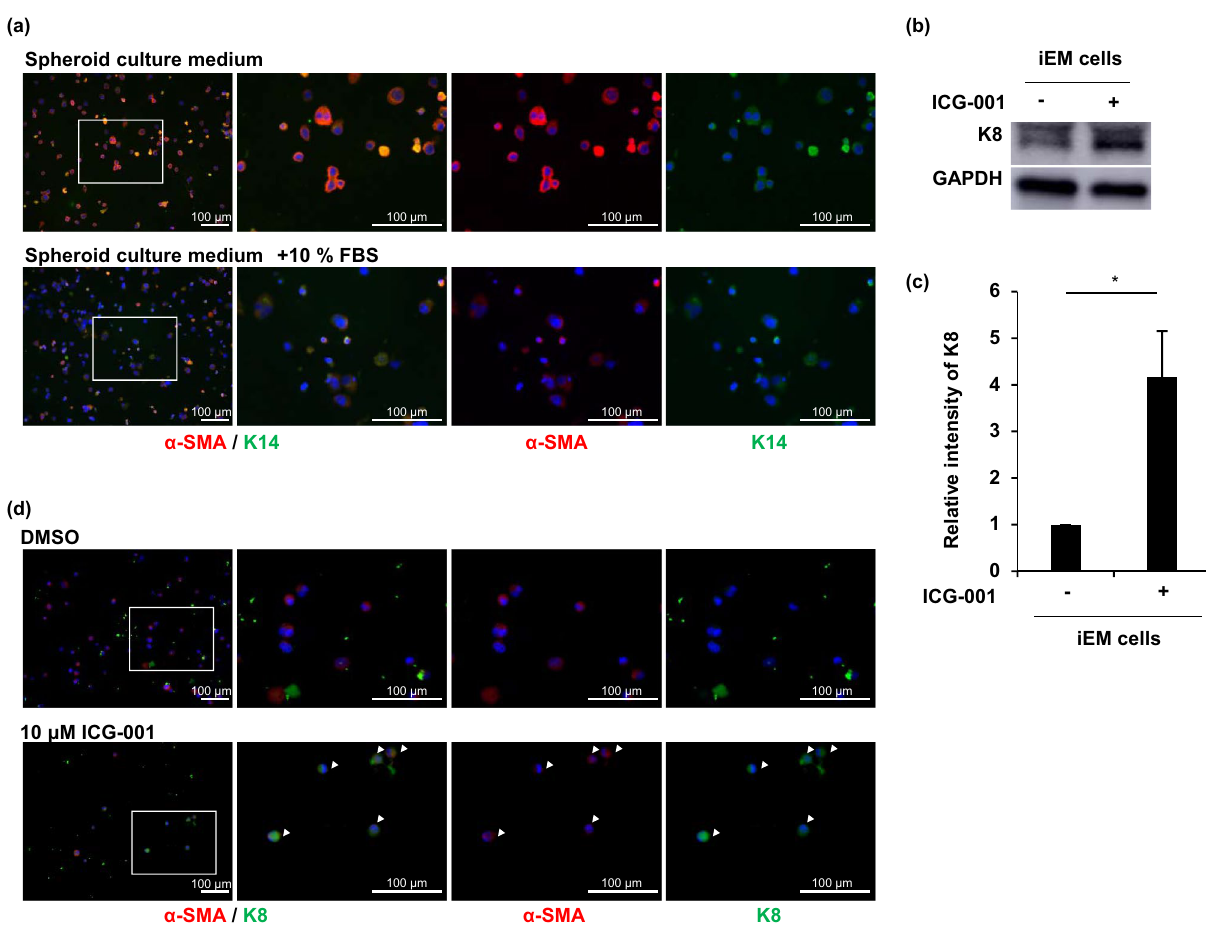
Figure 4. Immortalized eccrine sweat gland myoepithelial cells retain the potential of differentiation into luminal cells. ( a ) Immunofluorescence of immortalized myoepithelial (iEM) cells cultured with or without 10% fetal bovine serum (FBS) for α-smooth muscle actin (α-SMA) and keratin 14 (K14) for seven days. The second panels from the left are magnified views of the boxed areas in the left panels. Nuclei were stained with 4 ′ ,6-diamidino-2-phenylindole (DAPI). ( b ) Immunoblots of iEM cells treated with 10 μM ICG-001 (right) and dimethylsulfoxide (DMSO) (left) for keratin 8 (K8) and glyceraldehyde-3-phsphate dehydrogenase (GAPDH). ( c ) Relative quantitative values of K8 gene expression normalized to GAPDH gene expression. Quantification was performed using ImageJ software (version 1.53, https:// imagej. nih. gov/ ij/). Data are presented as the mean ± standard error (S.E.) of five independent experiments (n = 5). * P < 0.05. ( d ) Immunofluorescence for α-SMA (red) and K8 (green) of iEM cells cultured with 10 μM ICG-001 and DMSO for seven days. Arrowheads indicate K8-positive cells. The second panels from the left are magnified views of the boxed areas in the left panels. Scale bars: 100